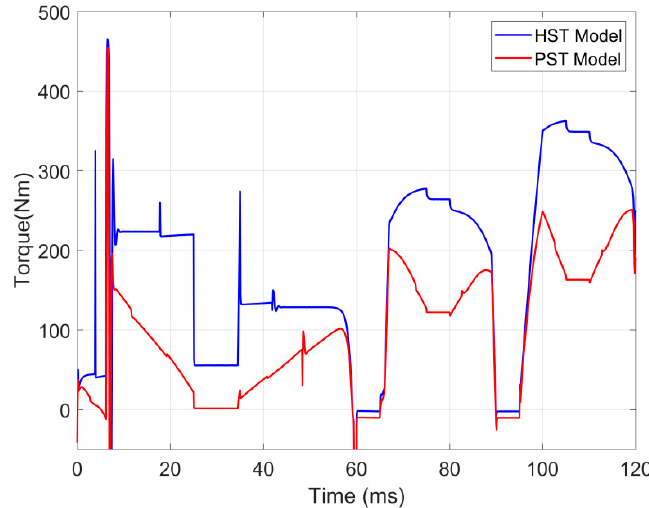
Figure 12. Hydraulic torque of Unit 2.